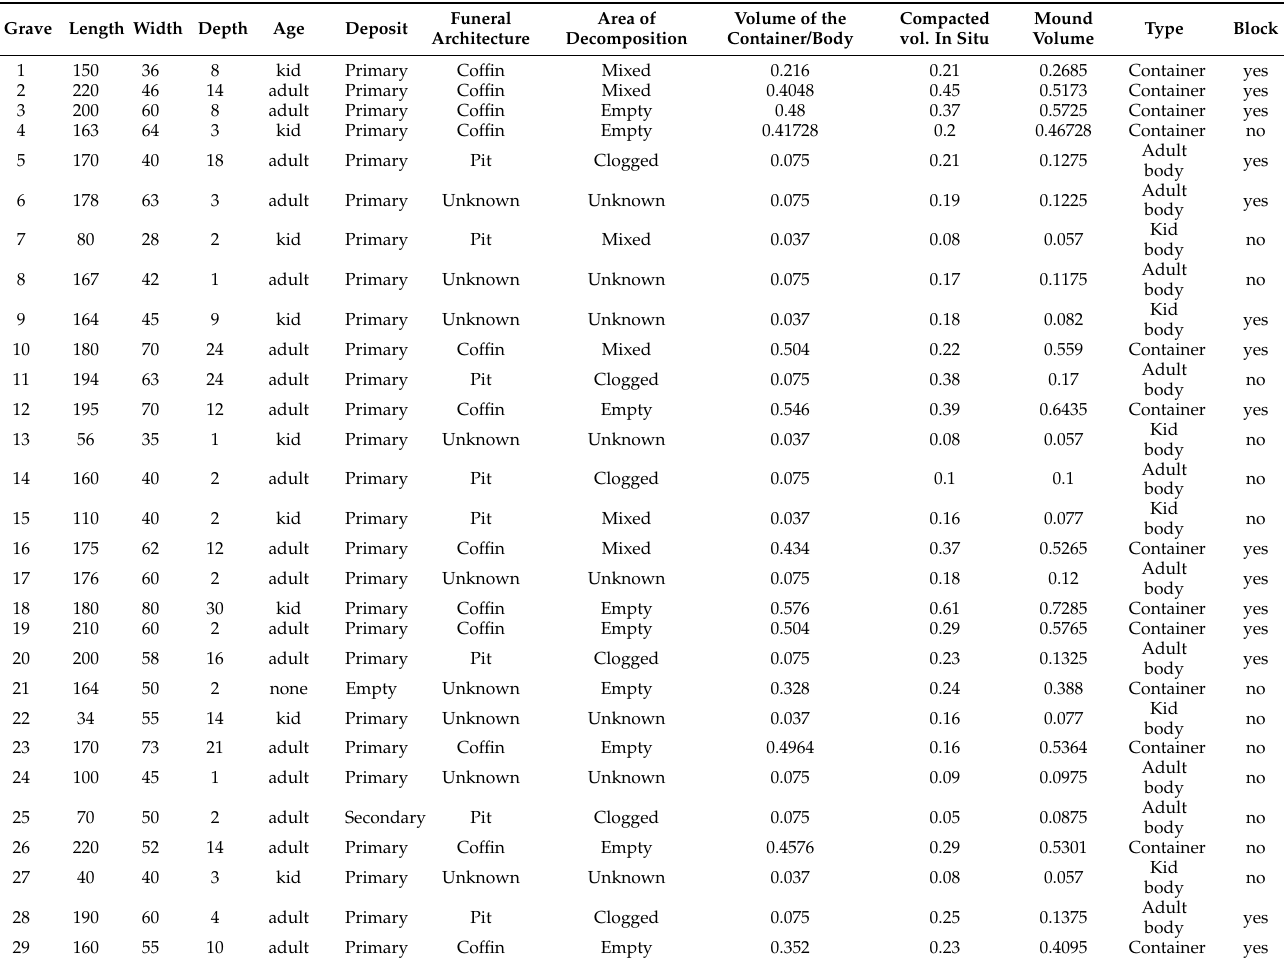
Table A1. The 14 Rue de la Paix, Olonne-sur-Mer graves